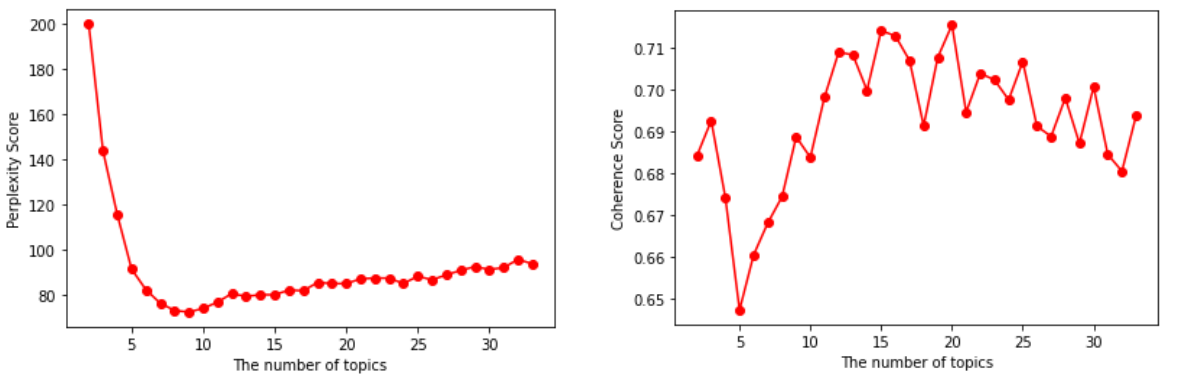
Figure 6. Visualization of topic coherence and perplexity